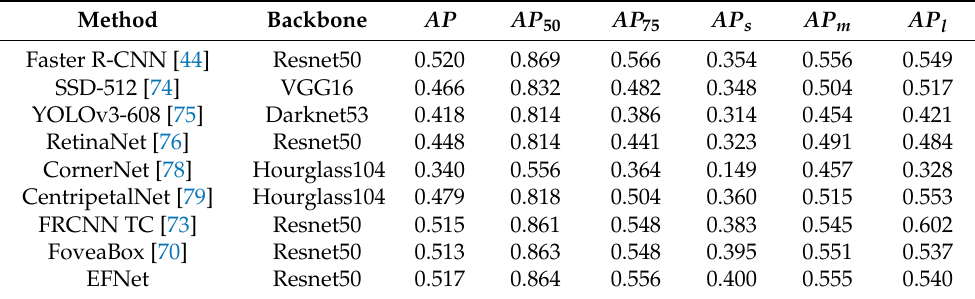
Table 5. Object-detection results of comparative methods on